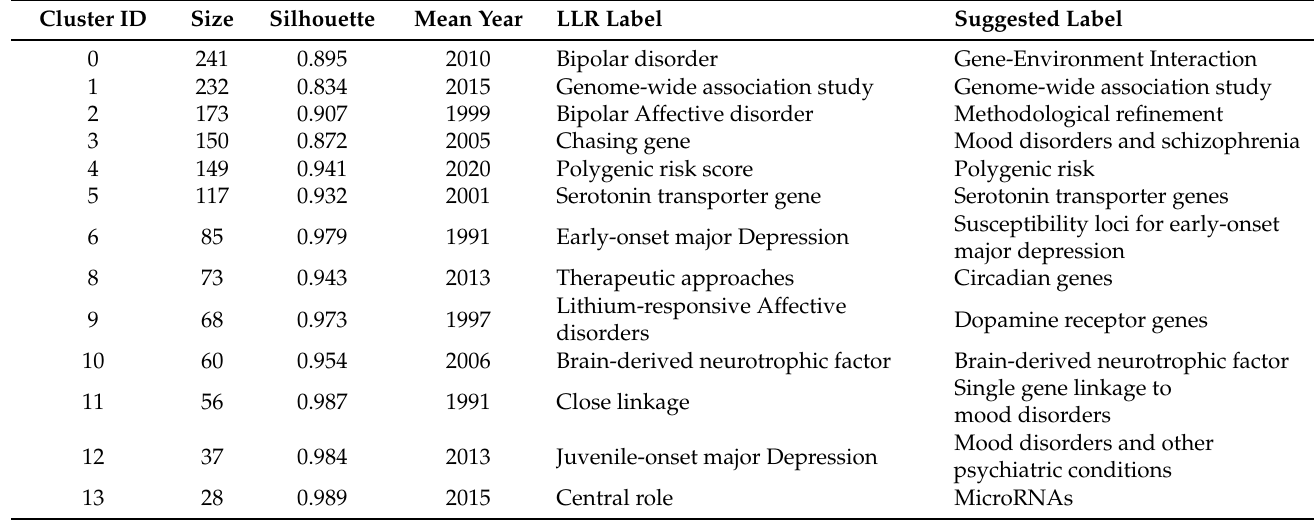
Table 1. Summary metrics for the 13 major clusters identified in the DCA